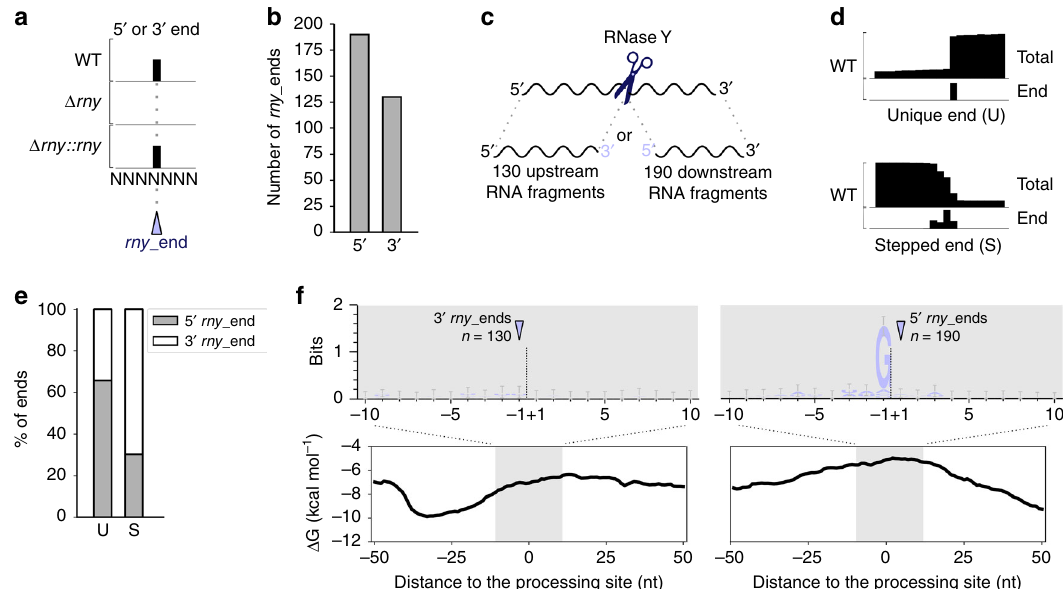
Fig. 1 RNase Y processes RNAs after a guanosine. a Representation of RNA end (5 ′ or 3 ′ ) pro fi ling obtained by RNA sequencing (performed in biological triplicates). The RNA ends that were more abundant in the wild type (WT) and complemented rny deletion strain ( Δ rny::rny ) than in the RNase Y deletion strain ( Δ rny ) are annotated as rny _end. “ NNNNNNN ” represents a sequence processed by RNase Y. b The bar plot shows the number of 5 ′ or 3 ′ ends that were more abundant in the WT than in the Δ rny strain (see Methods). c RNase Y cleavage (scissors) generates two processing products. We never retrieved both the RNA fragments upstream and downstream of the cleavage site for the same processing event. d Schematic drawing of total and end (5 ′ or 3 ′ ) coverages from RNA sequencing, illustrating RNA 5 ′ “ unique ” (U) and 3 ′ “ stepped ” (S) end positions. e Proportion of RNA 5 ′ and 3 ′ ends classi fi ed as U and S. f Sequence and structure conservation of the identi fi ed 5 ′ and 3 ′ rny _ends. The logo was created from the alignment of all sequences 10 nt on each side of the identi fi ed ends. Error bars are automatically calculated by the WebLogo library and correspond to an approximate Bayesian 95% con fi dence interval. The minimum free energy ( Δ G) was calculated at each nucleotide position using a sliding window of 50 nt over the entire genome. The average Δ G (kcal mol − 1 ) calculated for a window of 100 nt centred on the identi fi ed ends is depicted.